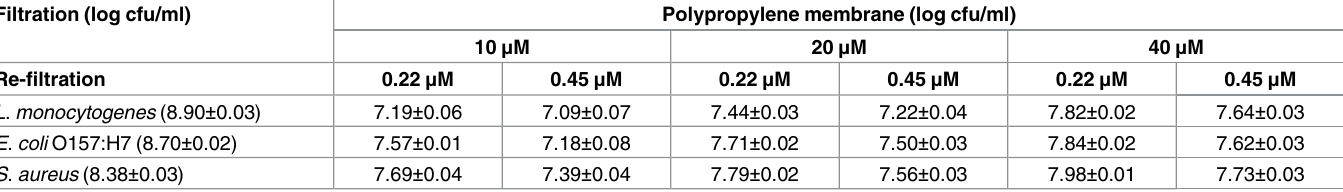
Table 3. Number of bacterial colonies for Listeria monocytogenes , Escherichia coli O157:H7,and Staphylococcus aureus inoculated on fresh-cut cantaloupe based on Polypropylene membrane. Filtration (log cfu/ml)